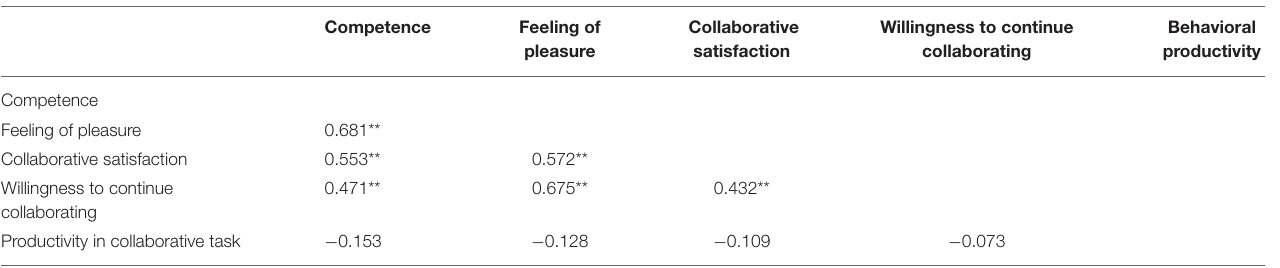
TABLE 3 | Correlation results of dependent variables in the